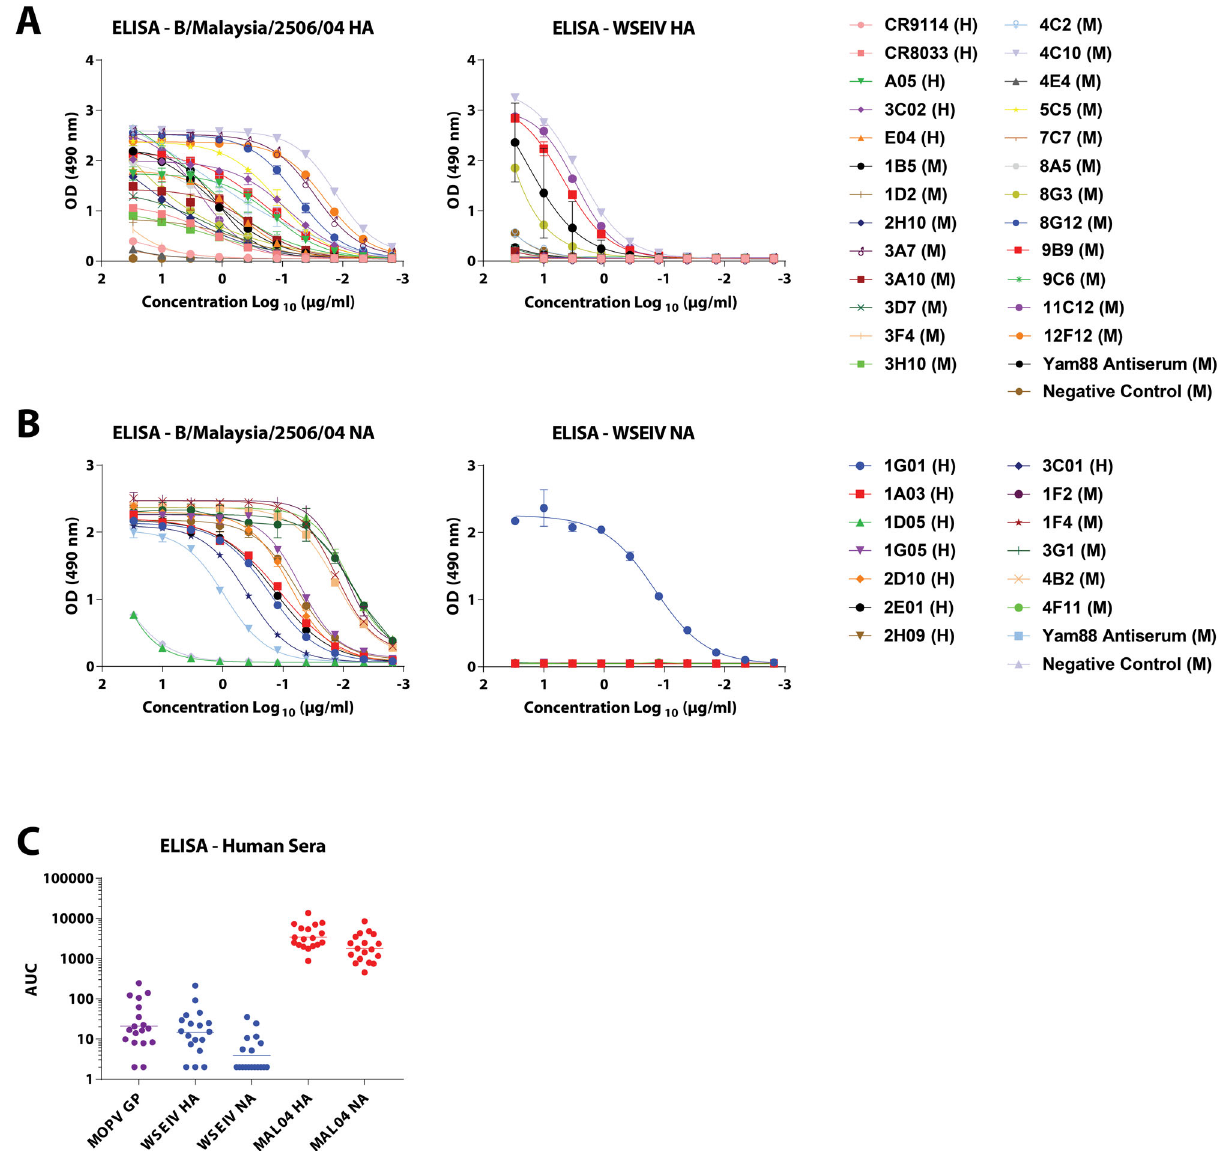
Fig. 4 Epitopes that are broadly conserved in in fl uenza B virus glycoproteins are largely absent the WSEIV HA and NA, with cross-reactivity being mostly restricted to the stalk domain of the HA and active site of the NA. A and B Binding pro fi les of broadly cross-reactive anti-in fl uenza B virus HA and NA human (H) and mouse (M) monoclonal antibodies in ELISAs are shown against recombinant B/Malaysia/2506/2004 and WSEIV HA and NAs. 4F11 (anti-in fl uenza B virus NA) and 4C2 (anti-in fl uenza B virus HA) mouse mAbs were used as negative controls for the ELISAs against the HAs and NAs respectively. C Presence of pre-existing immunity or induction of cross-reactive antibodies against the WSEIV HA and NA was evaluated through ELISAs using human serum samples obtained post-seasonal in fl uenza vaccination ( n = 18). Mopeia virus glycoprotein was used as a negative control for baseline establishment, and area under the curve was calculated with a cutoff of average plus three times the standard deviation of the blank wells. The geometric mean for each group is indicated with a line. Experiments were performed once in technical functionality compared to in fl uenza B virus NA. The data pro- vided in this study contribute to our overall understanding of in fl uenza B and in fl uenza B-like viruses, and to understanding of the pandemic potential of the in fl uenza B-like viruses from non- human reservoirs. expressed and puri fi ed from High Five cell culture supernatant as described in detail previously 16 . Phylogenetic and comparative sequence analysis . Phylogenetic trees for the HA and NA were generated as described previously 33 . Brie fl y, sequences were obtained from the Global Initiative on Sharing All In fl uenza Data (GISAID), aligned using